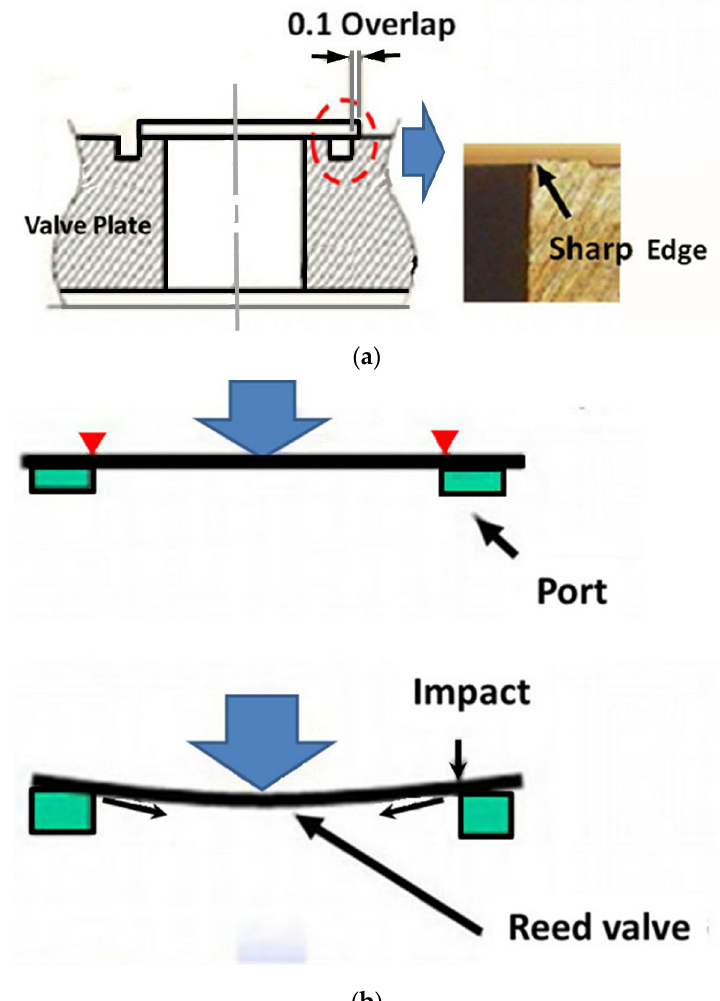
Figure 12. Structural design defects of suction reed and valve plate in a compressor: ( a ) overlapped suction reed valve and valve plate with sharp edge; ( b ) impact load in combination of design defects when compressor is worked.